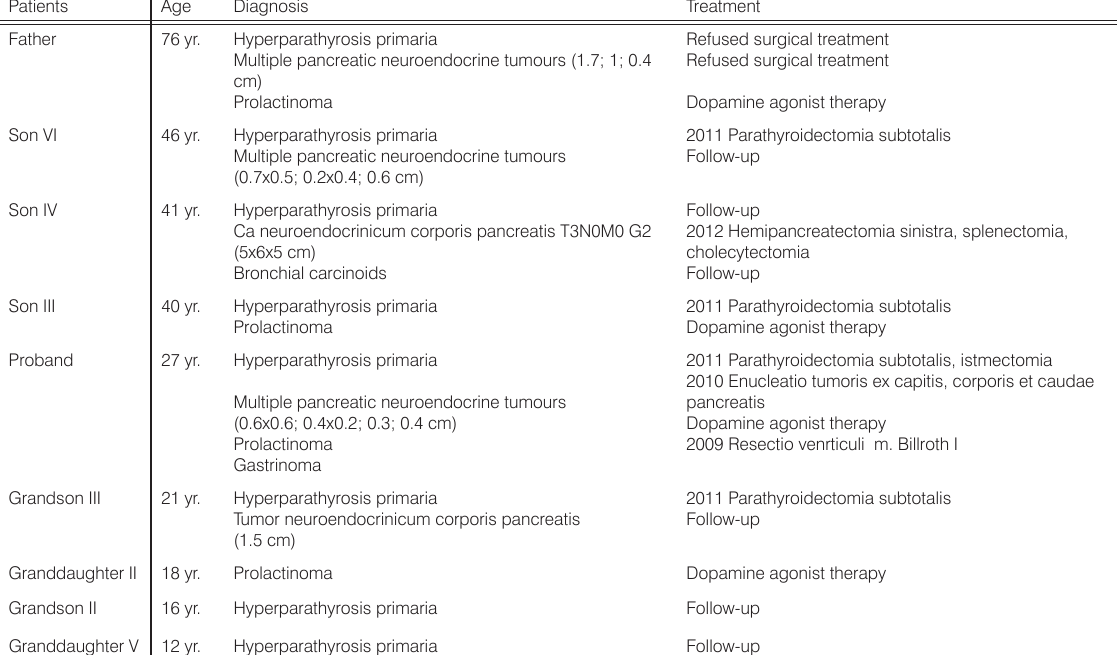
Table 1. Relatives and treatment.